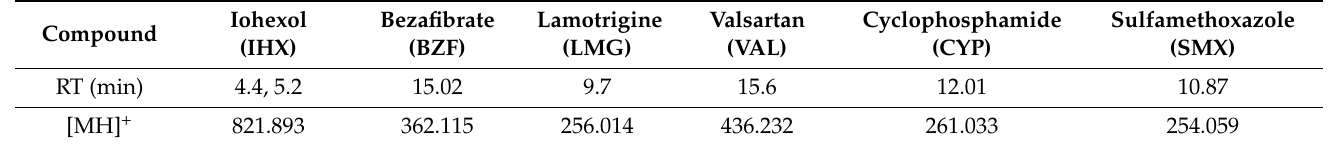
Table 9. LC-MS chromatographic characteristics of the selected pharmaceutical compounds. Compound